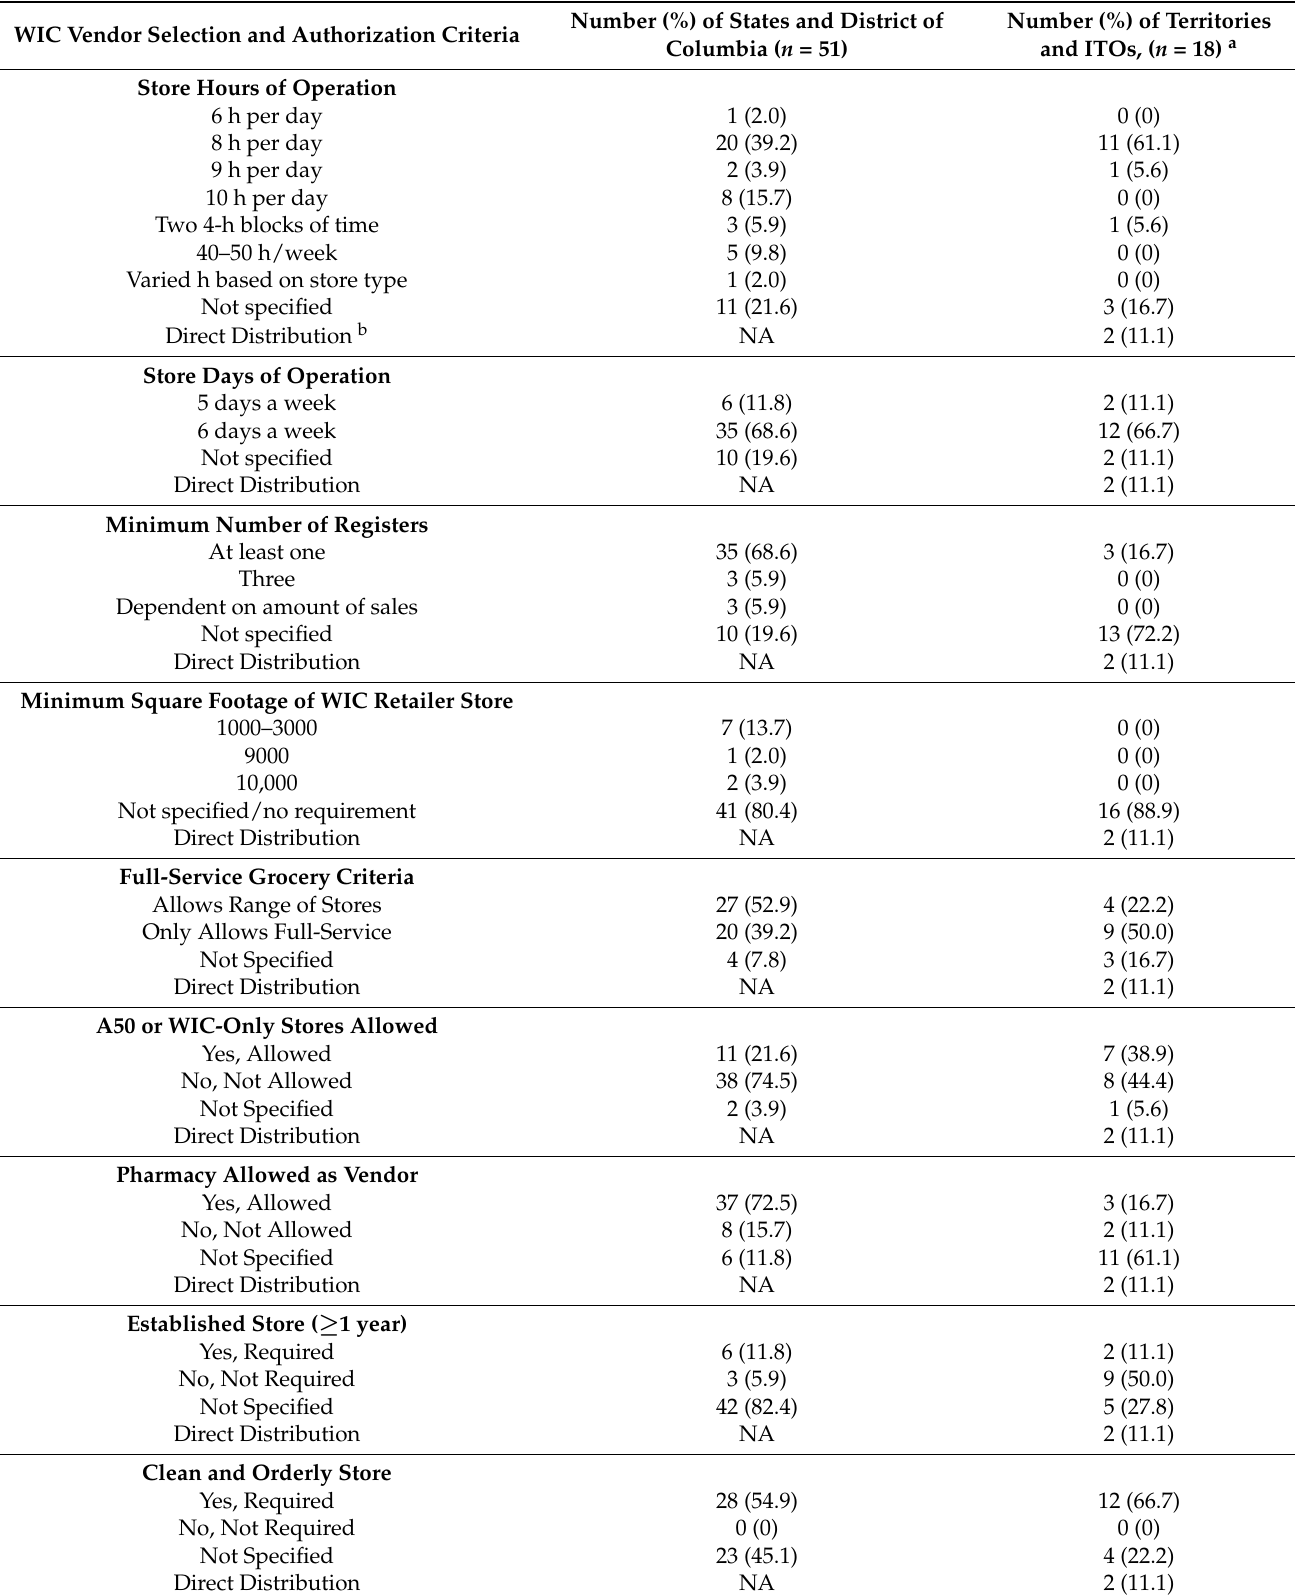
Table 2. Store-Specific Selection and Authorization Criteria for Administrative Agency-Authorized WIC Vendors, 2018–2020. WIC Vendor Selection and Authorization